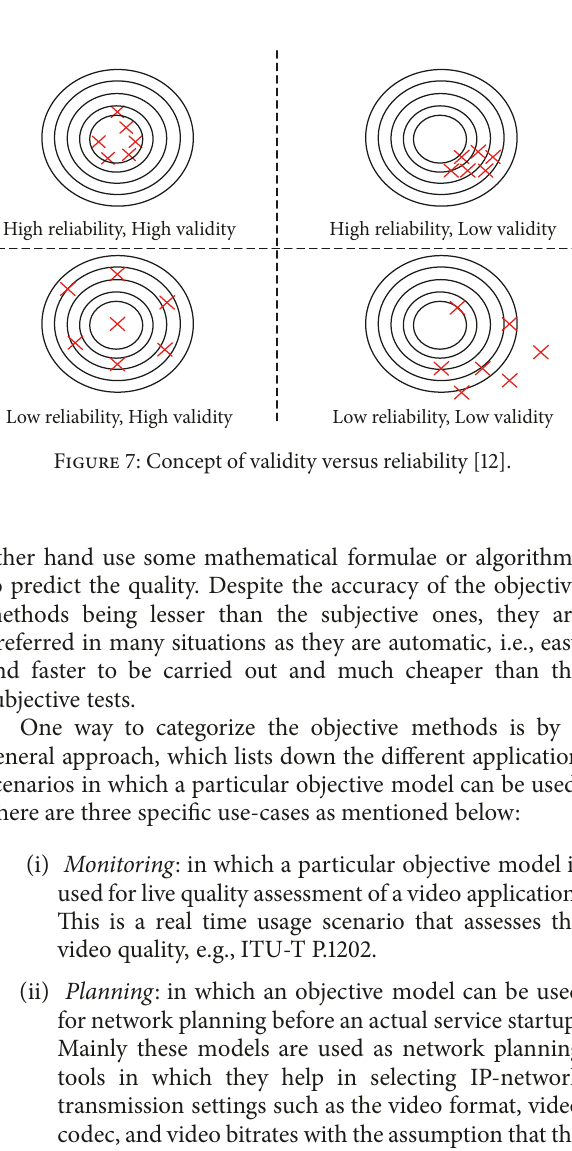
Figure 6: Categorization of different quality assessment methodologies by ITU for video applications.